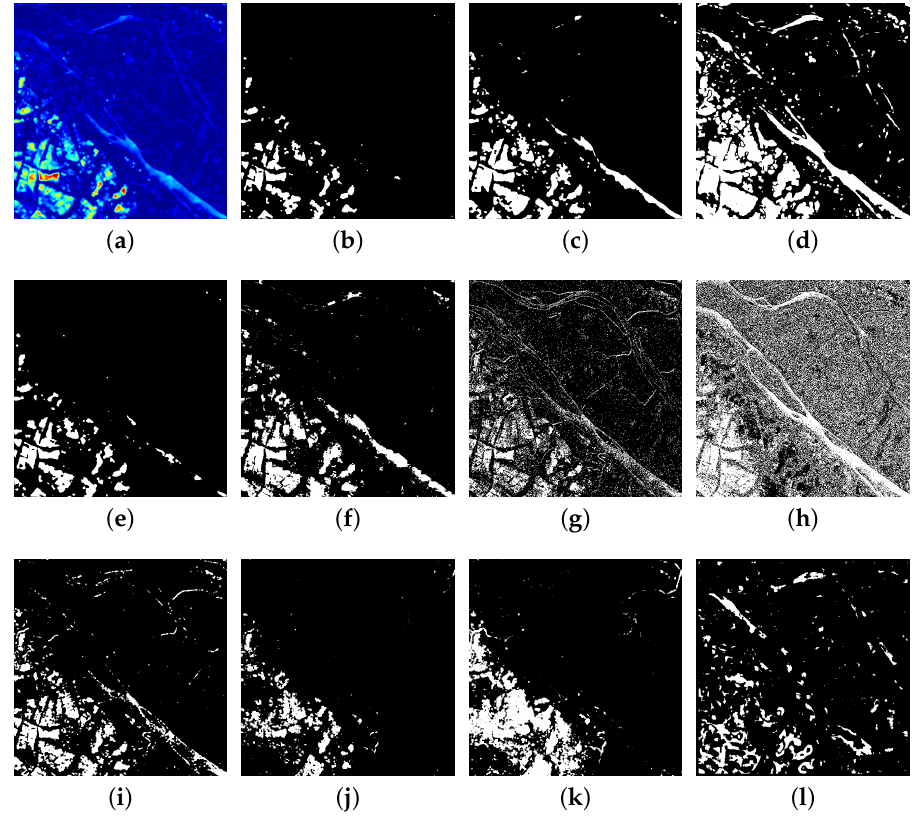
Figure 7. CMs of the different methods on Dataset #3. ( a ) DI of proposed method. ( b )